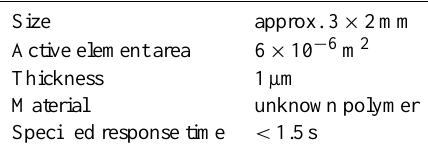
Figure 1. Sensitive element of a capacitive humidity sensor. The black polygon is the polymer between two gold electrodes. Table 1. Overview of P14 Rapid characteristics.